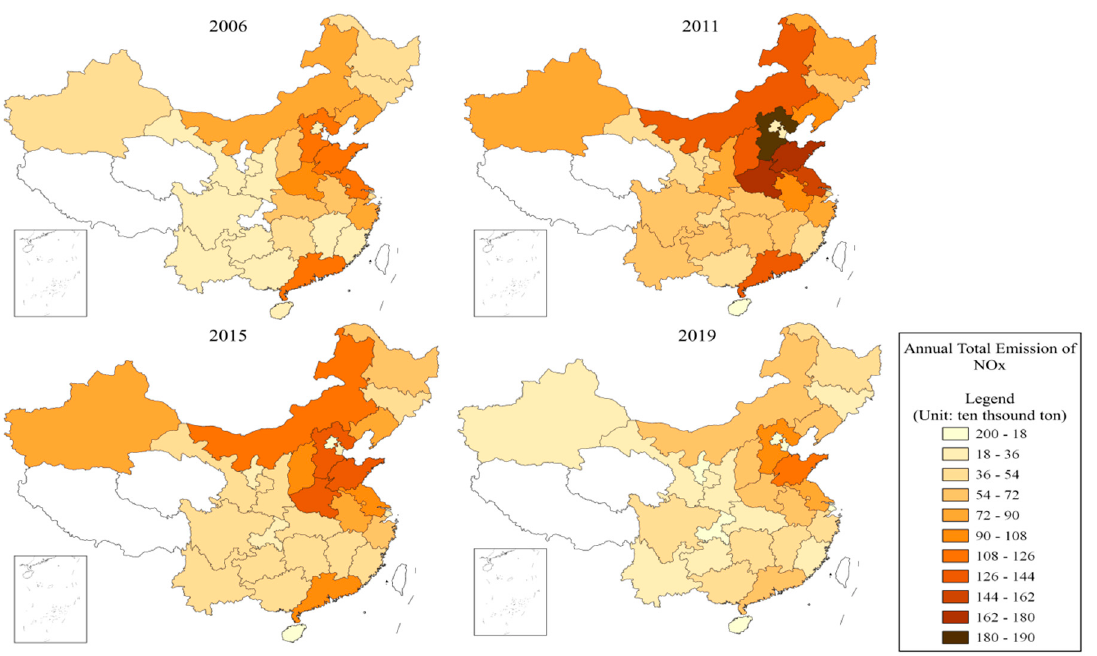
Figure 7. Distribution of NO x in Chinese provinces from 2006 to 2019 (Note: Figures 5–7 are plotted by the authors using the open-source software QGIS, which is permitted for free academic use under its protocol of usage; the data contained in the maps are public data from the China Statistical Yearbook on Environment. ).